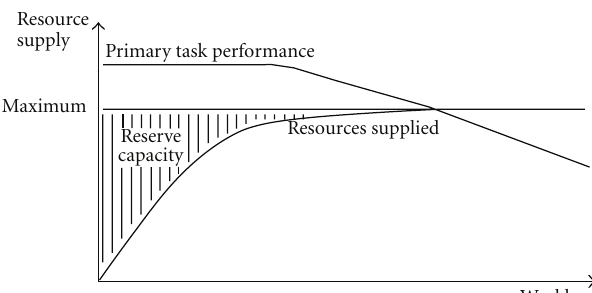
Figure 1: Capacity-based model of human dual-task performance (after